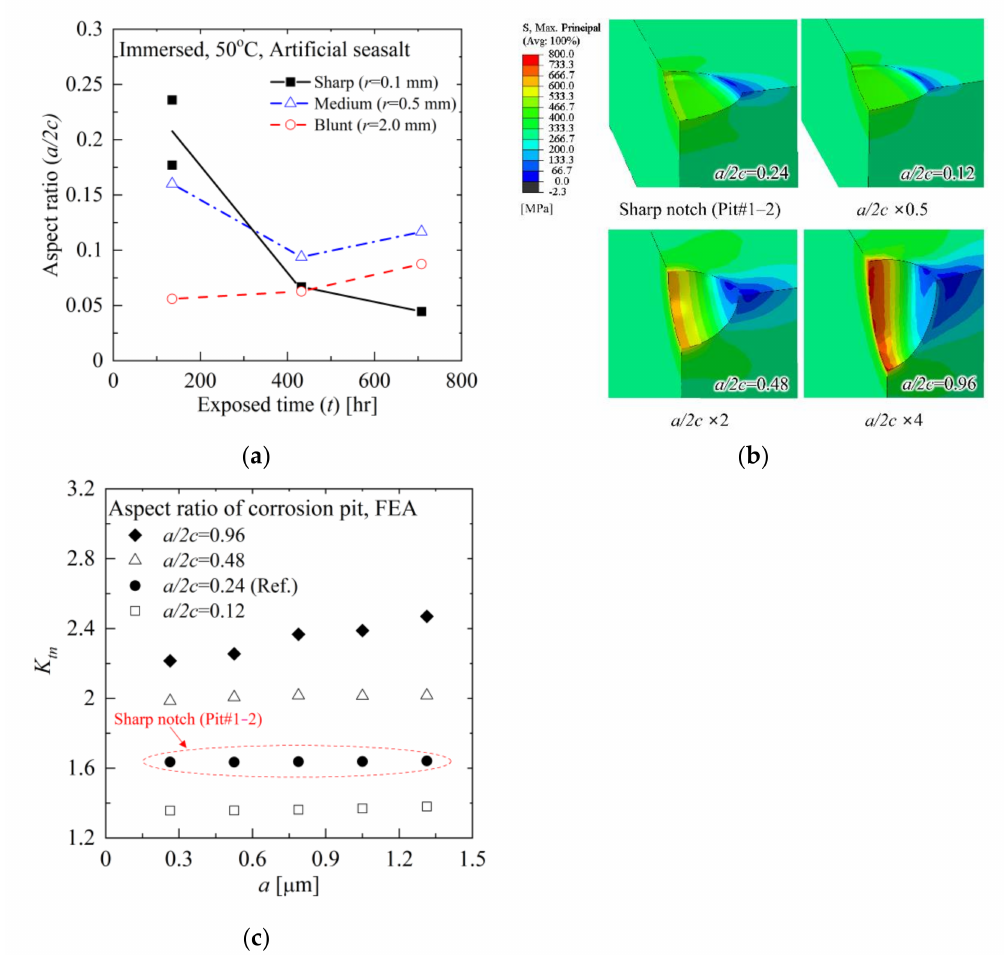
Figure 13. Analysis results of the aspect ratio effect on the stress in corrosion pits: ( a ) aspect ratio of observed corrosion pits, ( b ) FE analysis model for different aspect ratios (0.12–0.96), and ( c ) the effect of the aspect ratio on the stress concentration factor from FE